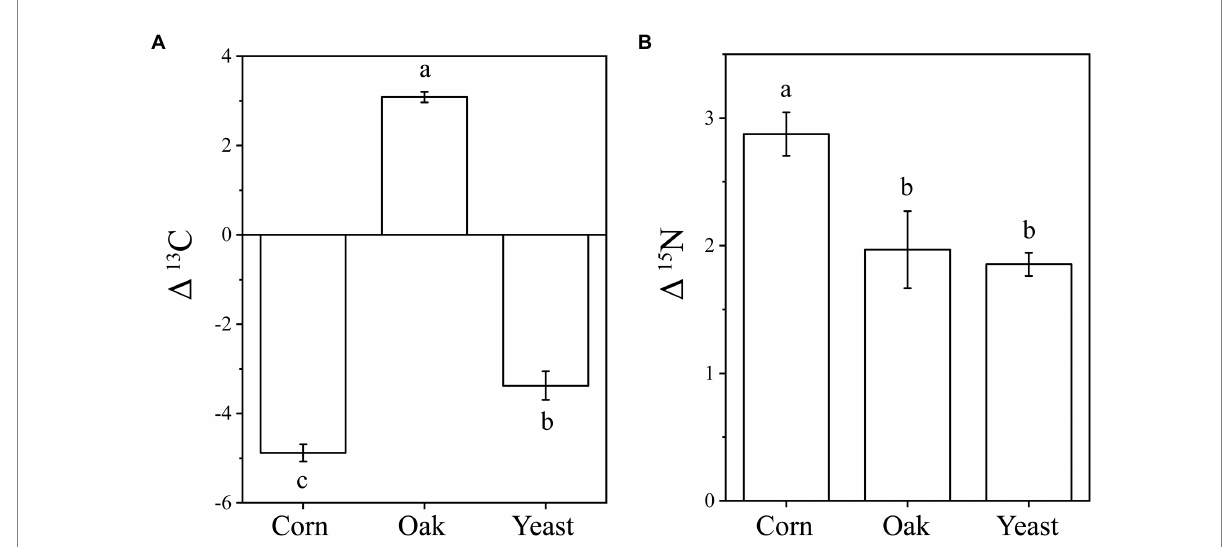
FIGURE 5 Stable isotopic enrichment of δ 13 C (A) and δ 15 N (B) in cold-adapted Collembola fed with different food resources. Different letters indicate significant differences between treatments ( p < 0.05) according to Tukey HSD